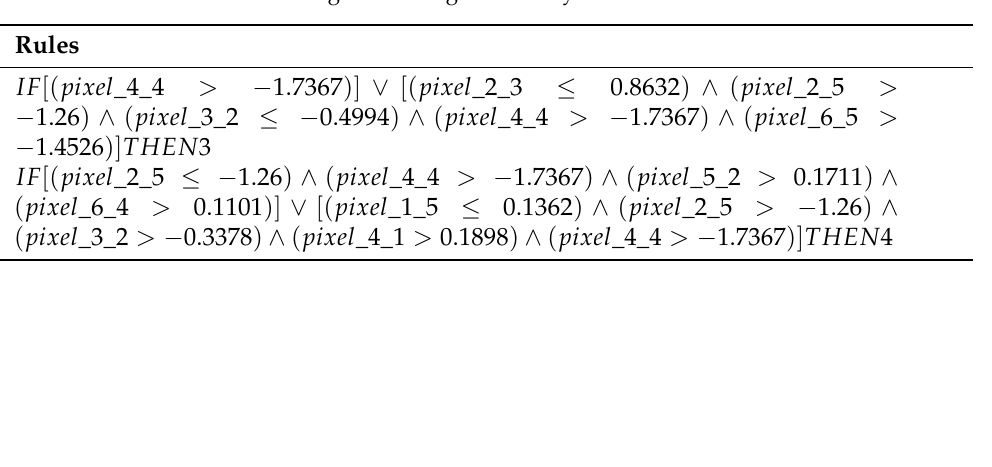
Table A16. Final rule set for the digits dataset generated by